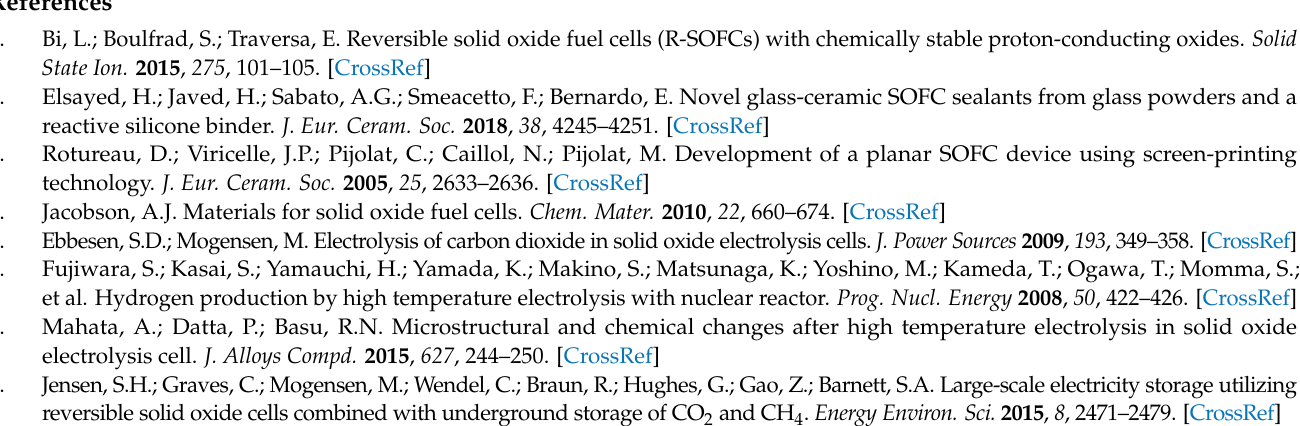
Figure A1. XRD analysis of thermally aged (1000 h, 850 °C) HJ14 glass-ceramic.